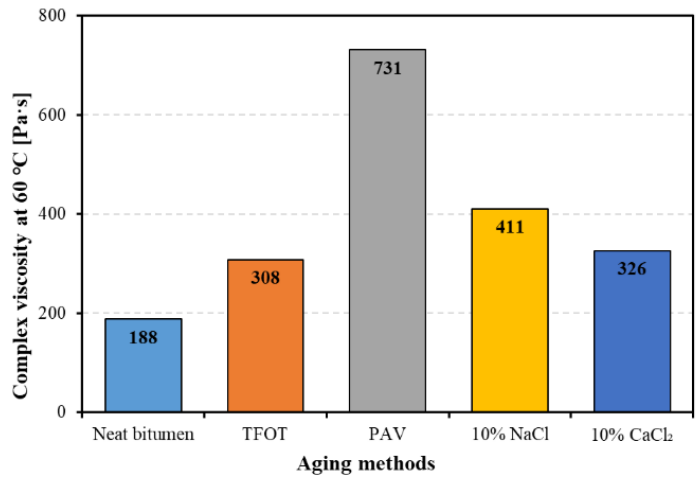
Figure 5. The complex viscosity of bitumen before and after aging.